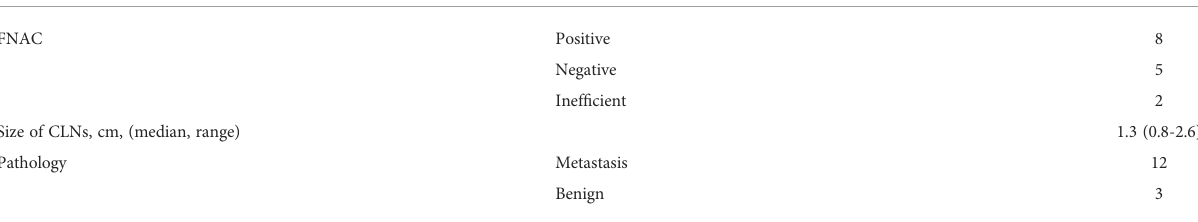
TABLE 3 Cases of CLNs with FNA-Tg between 1-3.69 ng/ml.